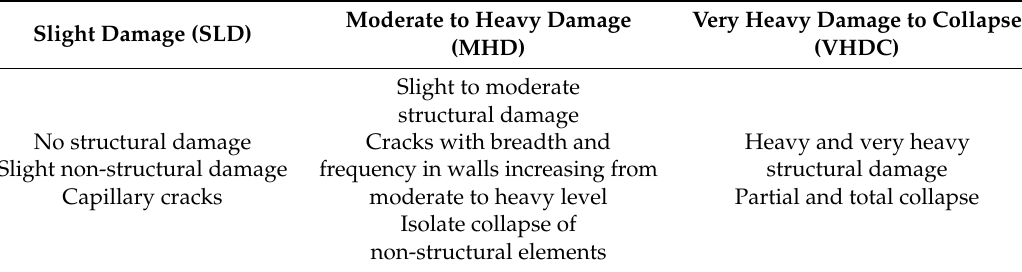
Table 1. Damage level classification: outline of the main inclusion / exclusion criteria used for the architectonic heritage of Avellino.